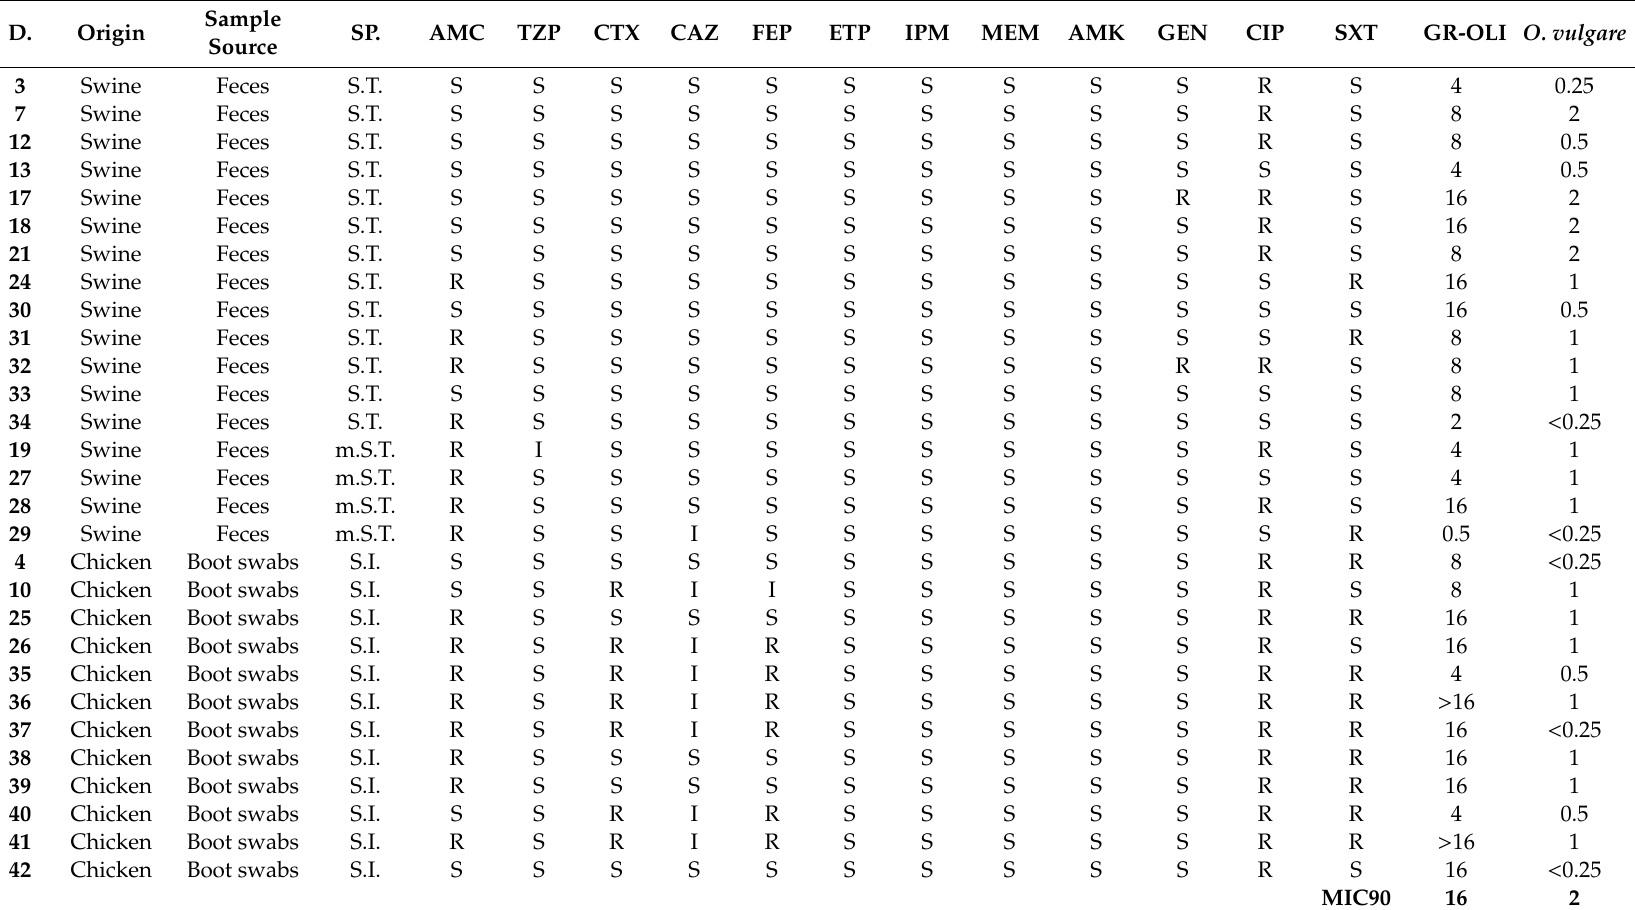
Table 2. Sensitivity of strains to antibiotics and natural